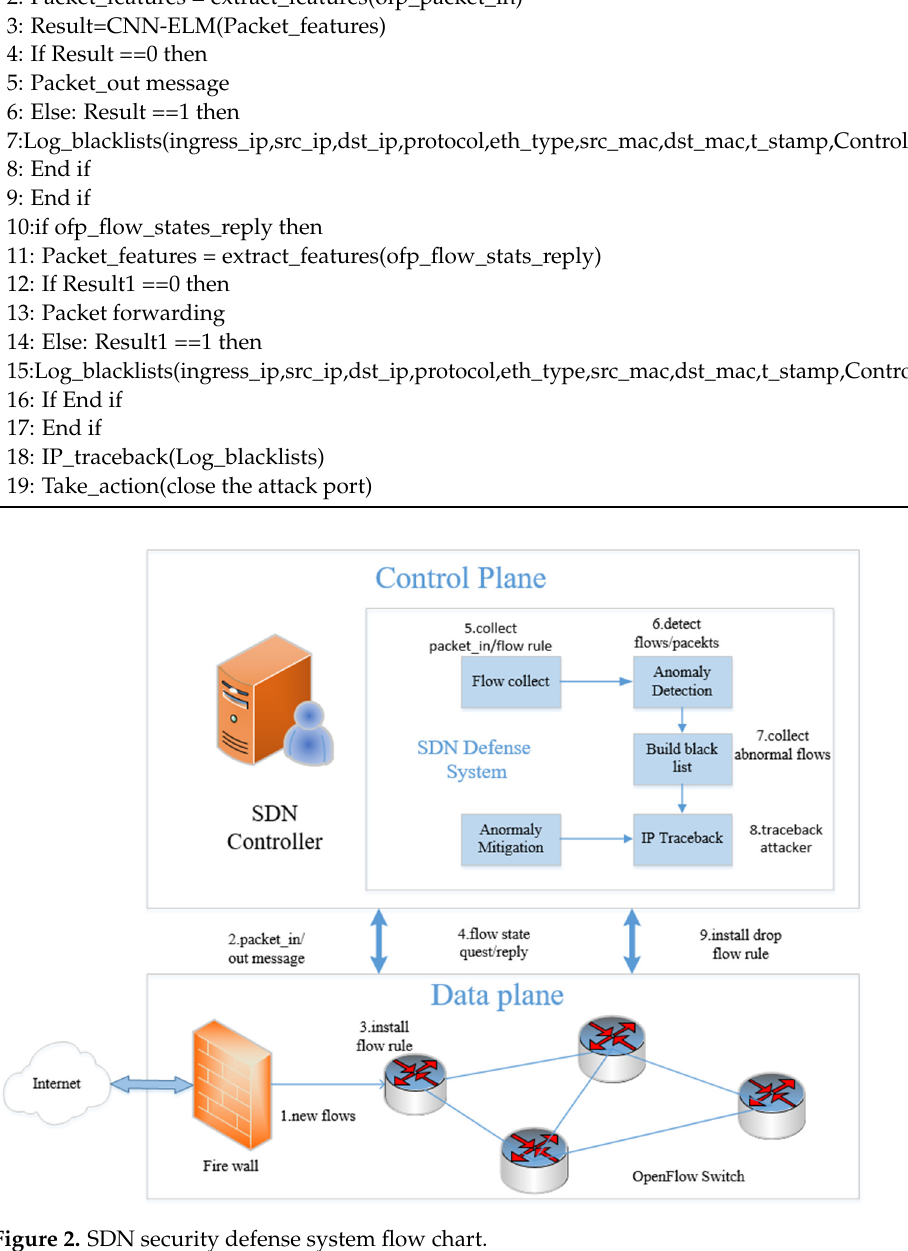
Figure 2. SDN security defense system flow